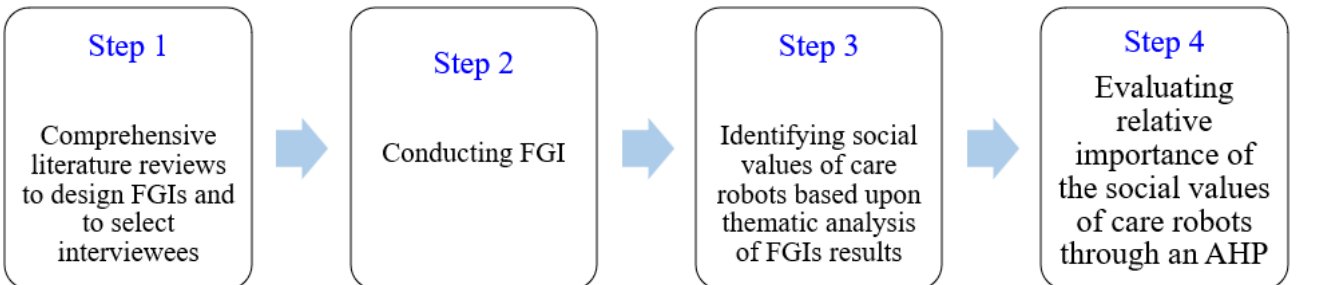
Figure 1. Research process of identifying the social values of care